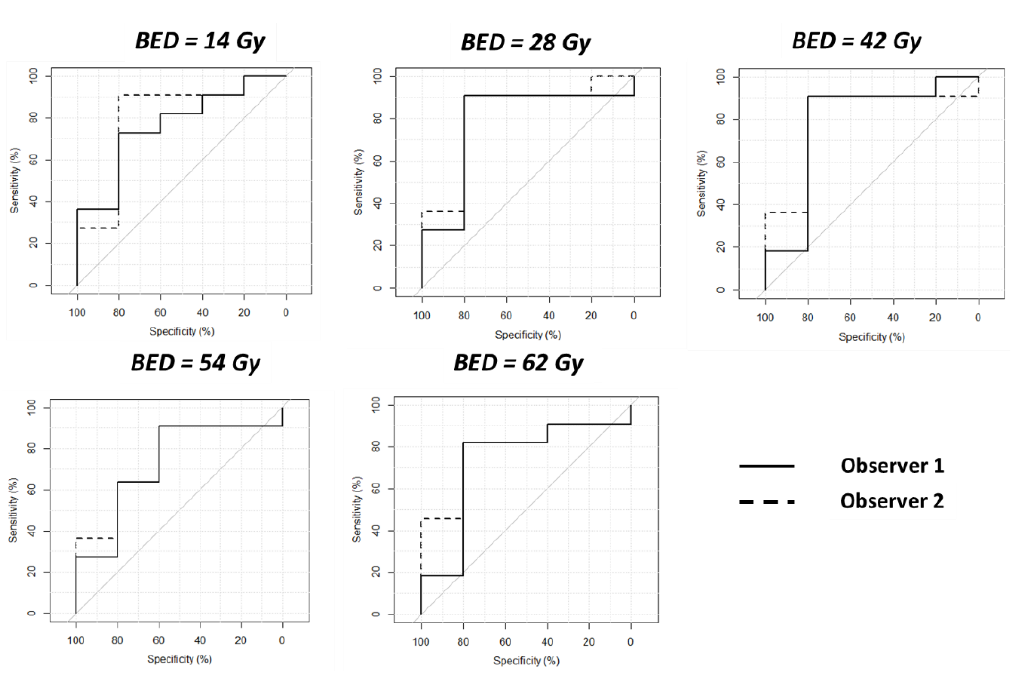
Figure 2. Receiver operating characteristic (ROC) curves calculated at different BED levels considering the two observers.